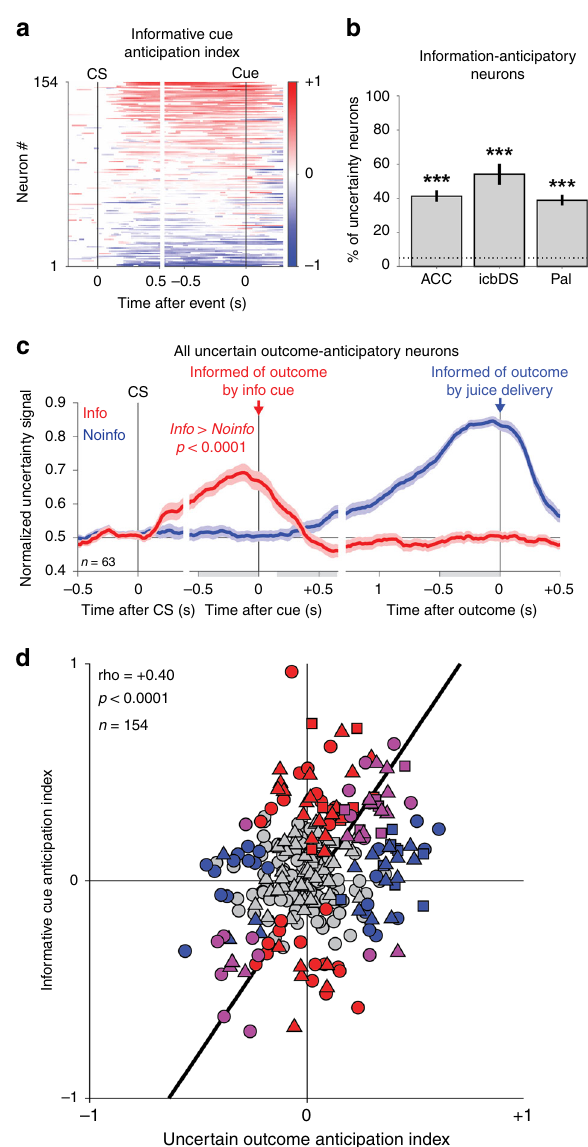
Fig. 3 Prevalence of information-anticipatory activity in the cortico-basal neuronsInformative cue ganglia network. a Uncertainty-related activity emerges preferentially anticipation index Information-anticipatory during the Info CS in anticipation of informative cues. Each row is a neuron, and colors indicate time points with a signi fi cant Informative Cue Anticipation Index (red: more positive uncertainty signal for Info, top; blue: more negative uncertainty signal for Info, bottom; color bar indicates scale). b Information-anticipatory activity was signi fi cantly present in many uncertainty-related neurons in each area (ACC, icbDS, and Pal: n = 26/63, 13/24, and 26/67). *** indicates signi fi cantly more neurons than expected by chance, ( p < 0.001, binomial test). c Information-anticipatory activity was prevalent in neurons anticipating uncertain outcomes. Shown are the population average uncertainty signals on Info CS (red) and Noinfo CS (blue) trials from the subset of neurons with a signi fi cant Uncertain Outcome Anticipation Index (blue, index measured only using Noinfo CS trials). The population has clear activity on Info CS trials in anticipation of viewing informative cues (red, text indicates p -value, rank-sum test). Error bars are ± 1 SE. Gray-shaded areas are the time windows for calculating the indexes of cue anticipation (pre-cue window) and outcome anticipation (post-cue, pre-outcome windows). d Correlated anticipation of the two reward-informative task events. Many neurons have signi fi cant Informative Cue Anticipation Indexes (red, y -axis, p < 0.05, permutation test), Uncertain Outcome Anticipation Indexes (blue, x -axis), or both (purple). The two indexes are highly correlated; text indicates rank correlation and its p-value. ACC, icbDS, and Pal neurons are indicated by triangles, squares, and circles. Black line is a linear fi t with type 2